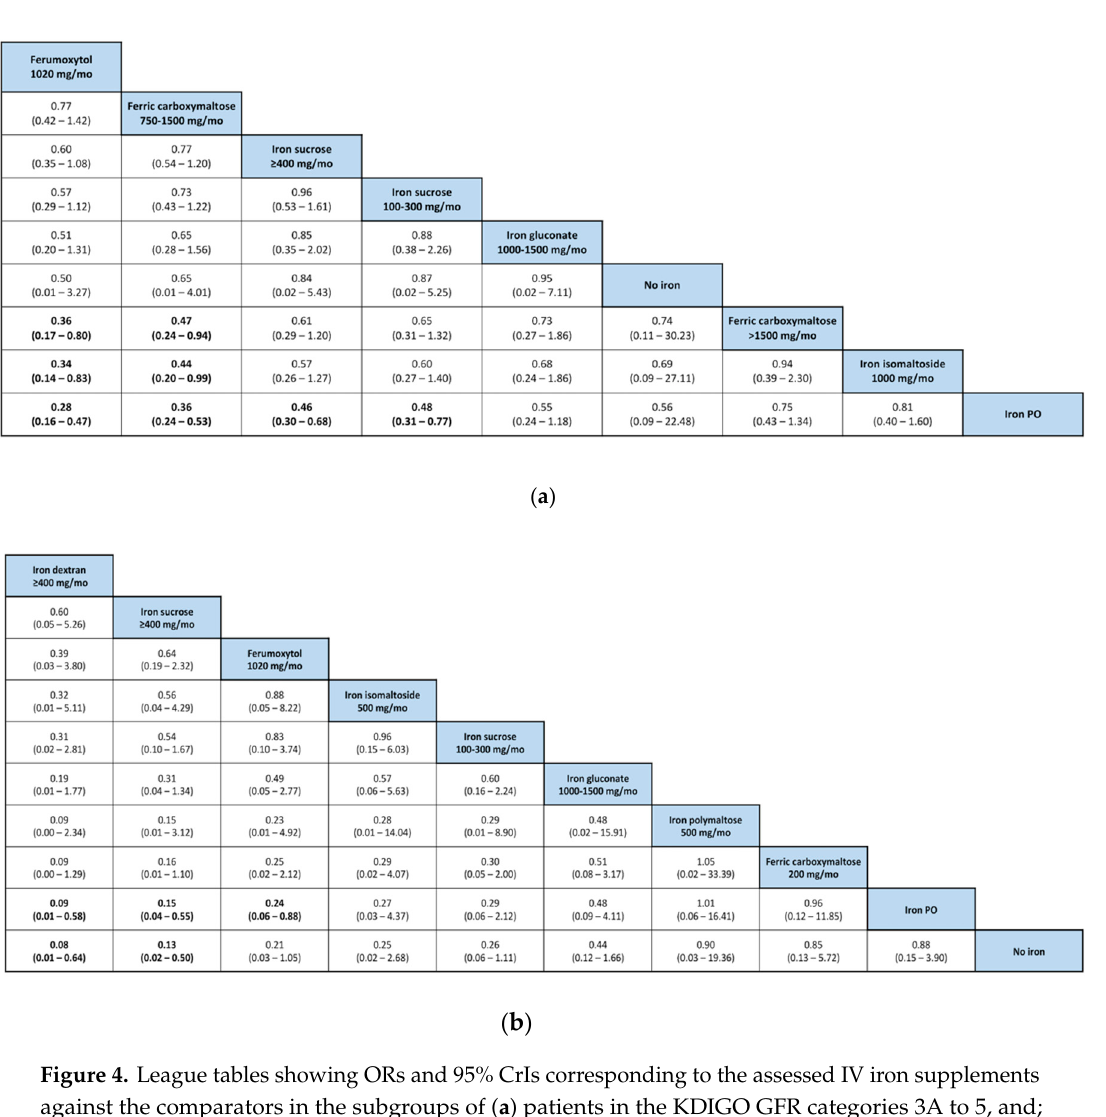
Figure 3. Bayesian network diagrams presenting the density in the comparisons (thickness of lines according to the number of RCTs in each comparison) and the competing iron supplements (node size according to the number of participants undergoing interventions) for the subgroups of ( a ) patients in the KDIGO GFR categories 3A to 5, and; ( b ) dialysis patients. GFR, Glomerular filtration rate; KDIGO, Kidney Disease—Improving Global Outcomes; RCT, randomized controlled trial.